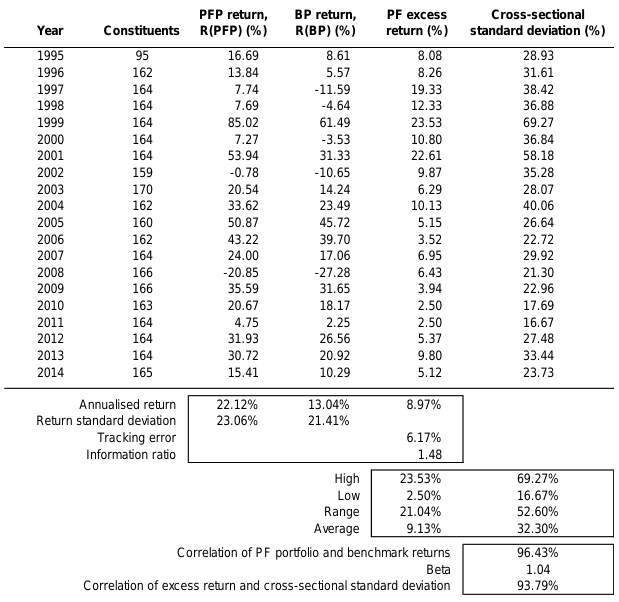
Figure 2: PF excess return and cross-sectional standard deviation by 5-year